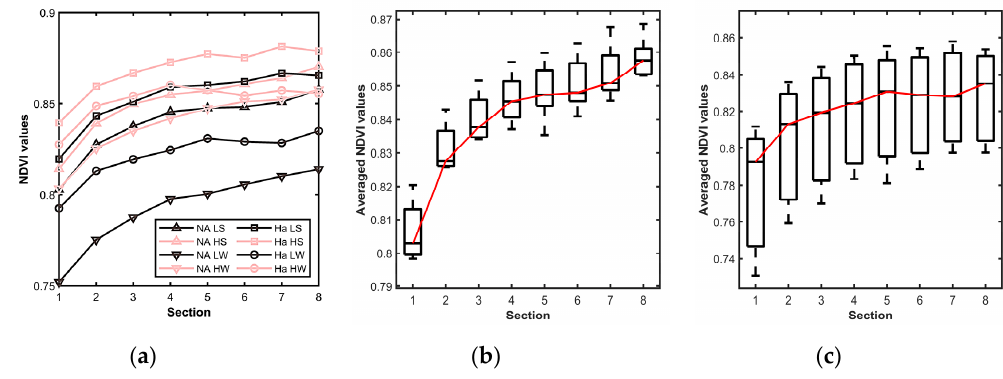
Figure 10. Distribution of NDVI values across soybean leaves. ( a ) NDVI values of each section of all groups, HS for high N and drought-stressed; HW for high N and well-watered; LS for low N and drought-stressed; LW for low N and well-watered, NA for NAM_IA genotype, and Ha for Harsoy genotype. ( b ) Averaged NDVI values of each section of drought-stressed and low N treated NAM_IA plants group (P < 0.0001 by one-way ANOVA). ( c ) Averaged NDVI values of each section of well-watered and low N treated Harsoy plants group (P = 0.176 by one-way ANOVA).